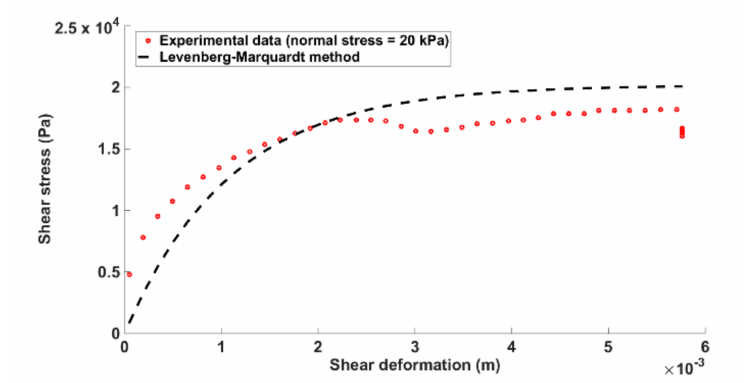
Figure 4. Experimental results of direct-shear test for identifying the terrain characteristics associated with shear stress on the lunar simulant using the Mohr–Coulomb failure criterion.